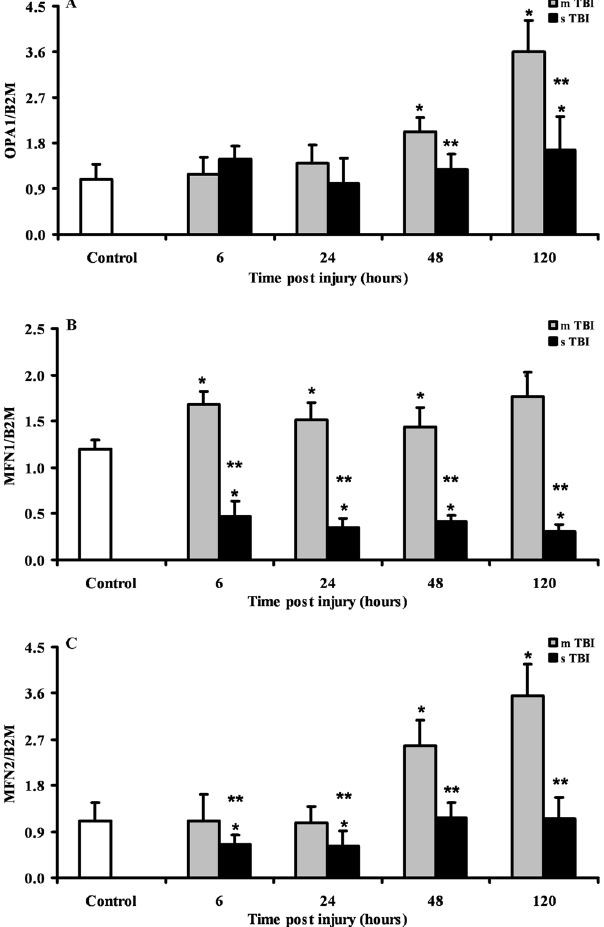
Figure 1. Changes in the expression of fusion-related genes (OPA1, MFN1 and MFN2) in brain tissue homogenates of rats receiving different severities of TBI (mTBI and sTBI) at various times post-impact. Values are the mean of 6 animals. Standard deviations are represented by vertical bars. Gene expressions were calculated relatively to the housekeeping gene β -2-microglobulin (B2M). * Significantly different from controls, p < 0.05. ** Significantly different from the corresponding time of mTBI rats, p <